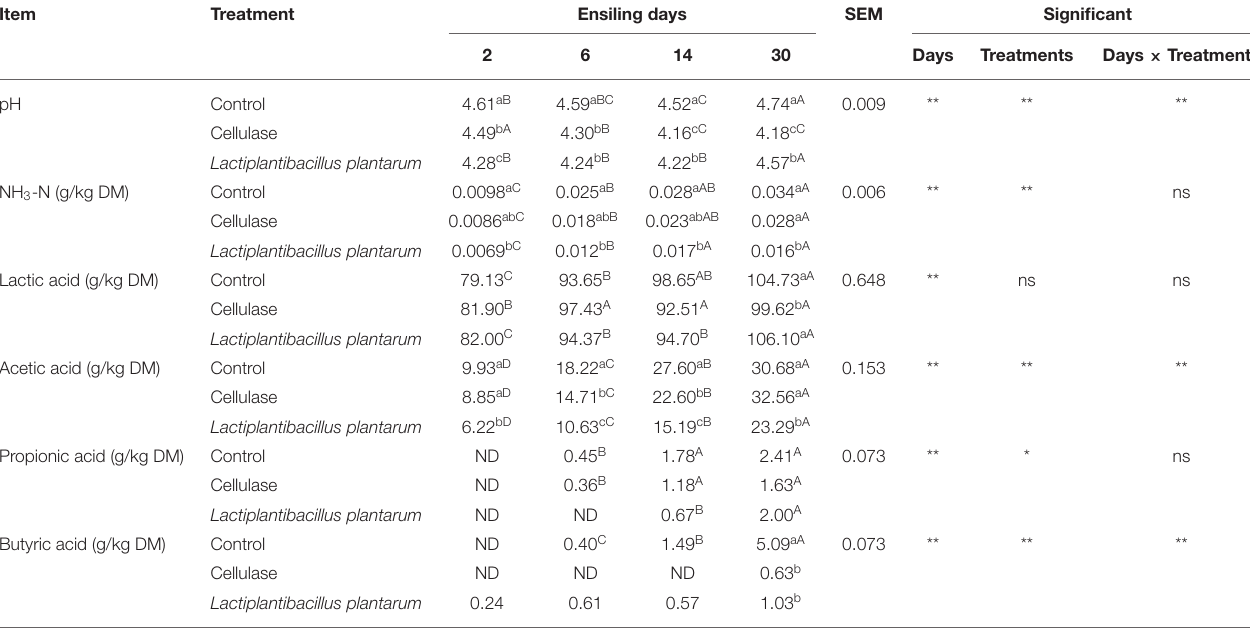
TABLE 2 | Fermentation parameters of ensiled Cassia alata .